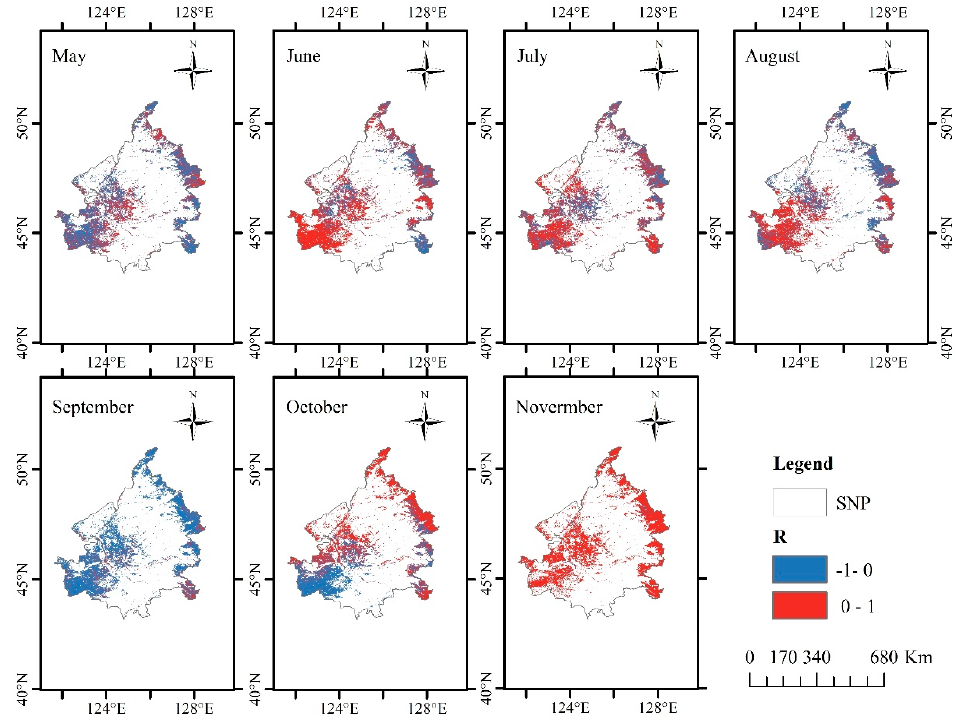
Figure 14. Correlation coefficients between CUE and temperature at monthly scale during 2001–2015. Table 3. The number of pixels and their proportions of the correlation coefficients between monthly temperature and CUE.